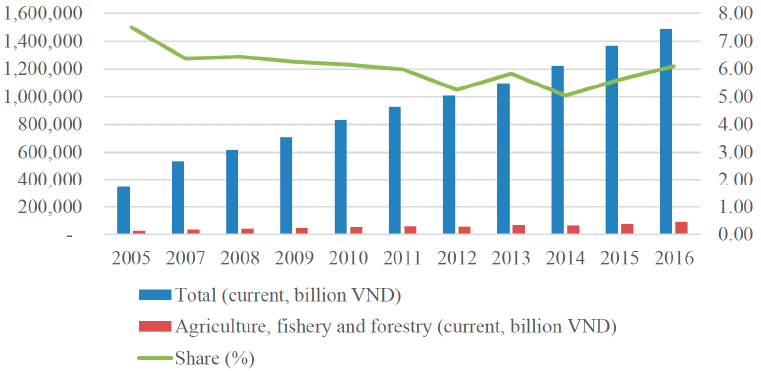
Figure 2. Share of agriculture in the GDP and employment (Data from: https://lienvietpostbank.com.vn/ [3]).